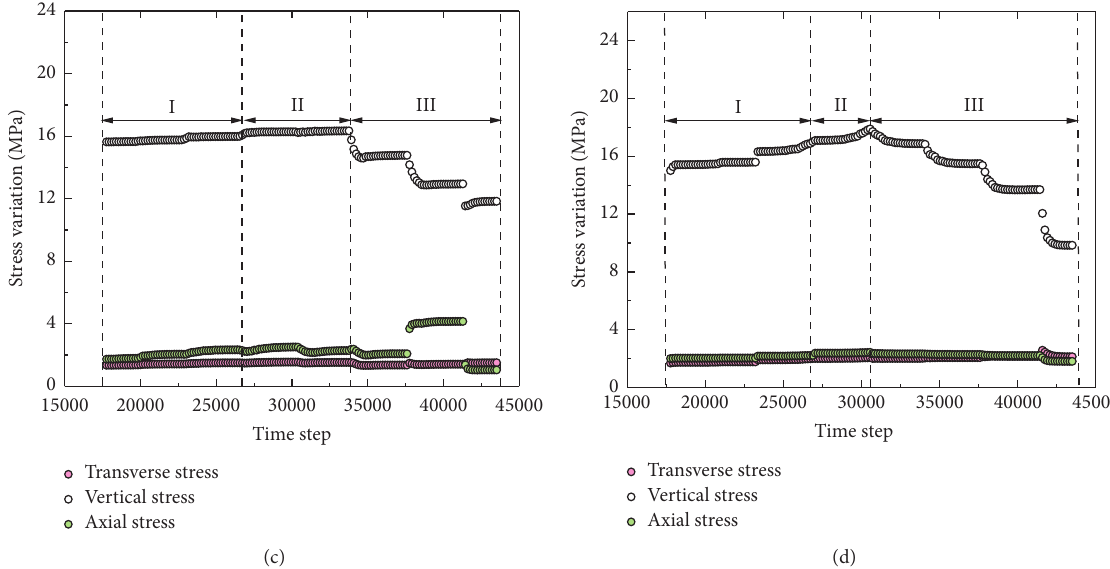
Figure 13: Numerical simulation results: (a) − 325 horizontal section, (b) − 350 horizontal section, (c) − 375 horizontal section, and (d) − 400 horizontal